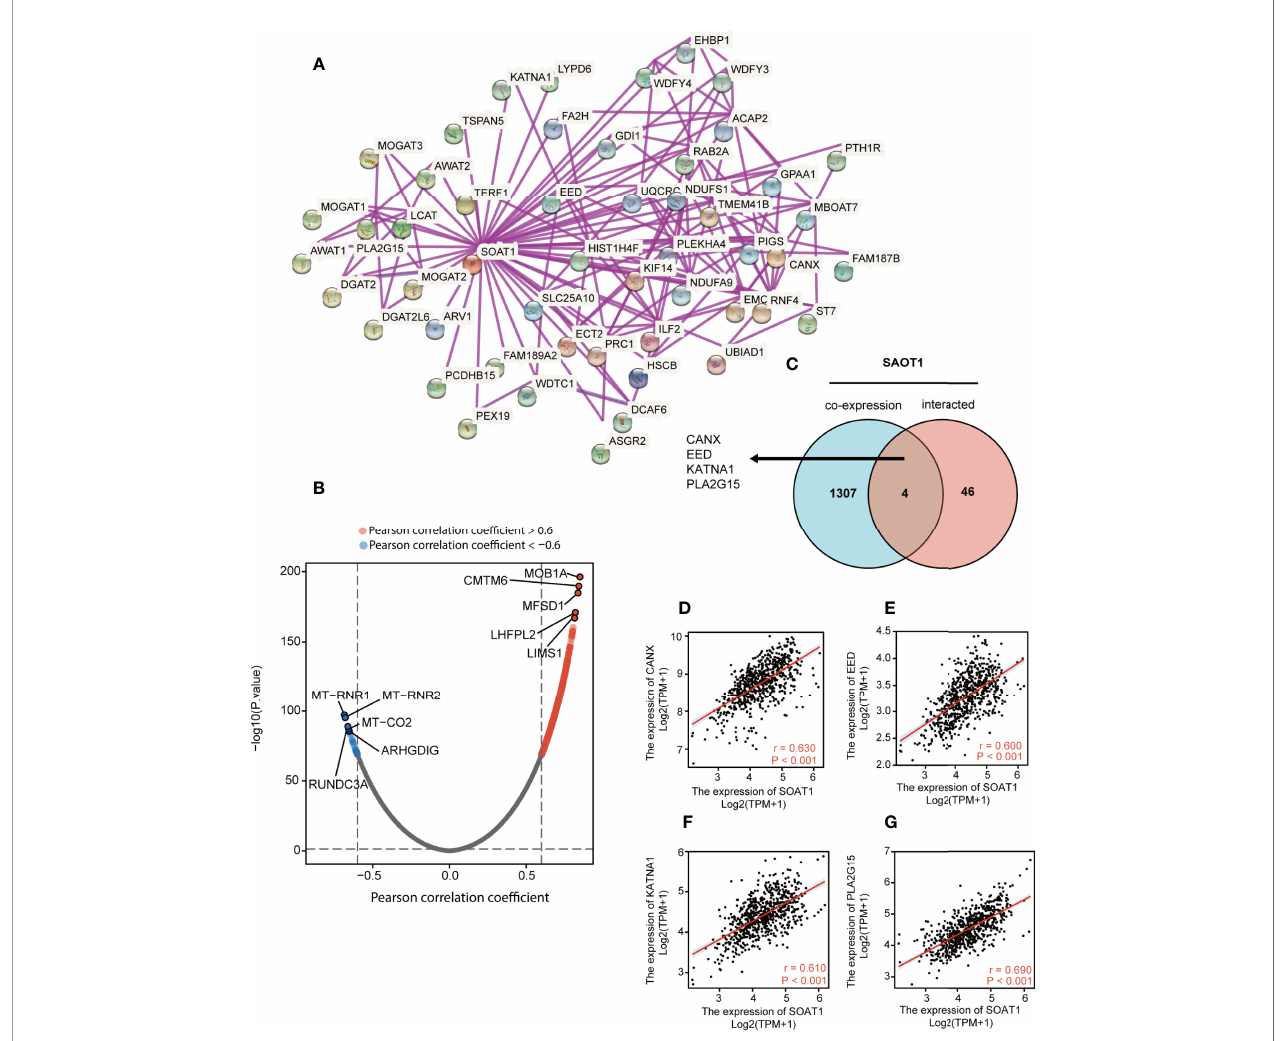
FIGURE 8 | PPI network and co-expression analysis of SOAT1 in glioma. (A) A PPI network of SOAT1 was constructed using the STRING website. (B) Co- expression analysis of SOAT1 in glioma based on the TCGA cohort (C) An intersection analysis of SOAT1 co-expression analysis and PPI network was performed by Venn diagram. (D – G) Pearson ’ s correlation coef fi cient of CANX, EED, KATNA1 , and PLA2G15 with SOAT1 expression in glioma, respectively. PPI, protein-protein interaction; CANX , calnexin; EED , embryonic ectoderm development; KATNA1 , katanin catalytic subunit A1; PLA2G15 , phospholipase A2 group XV; STRING, Search Tool for the Retrieval of Interacting Genes/Proteins; TCGA, The Cancer Genome Atlas; SOAT1 , sterol O-acyltransferase 1